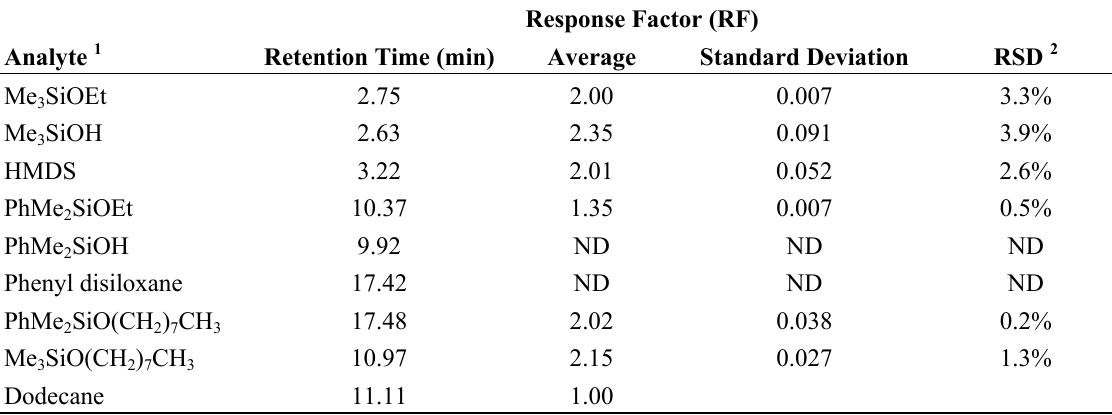
Table 4. GC-FID analyte retention times and response